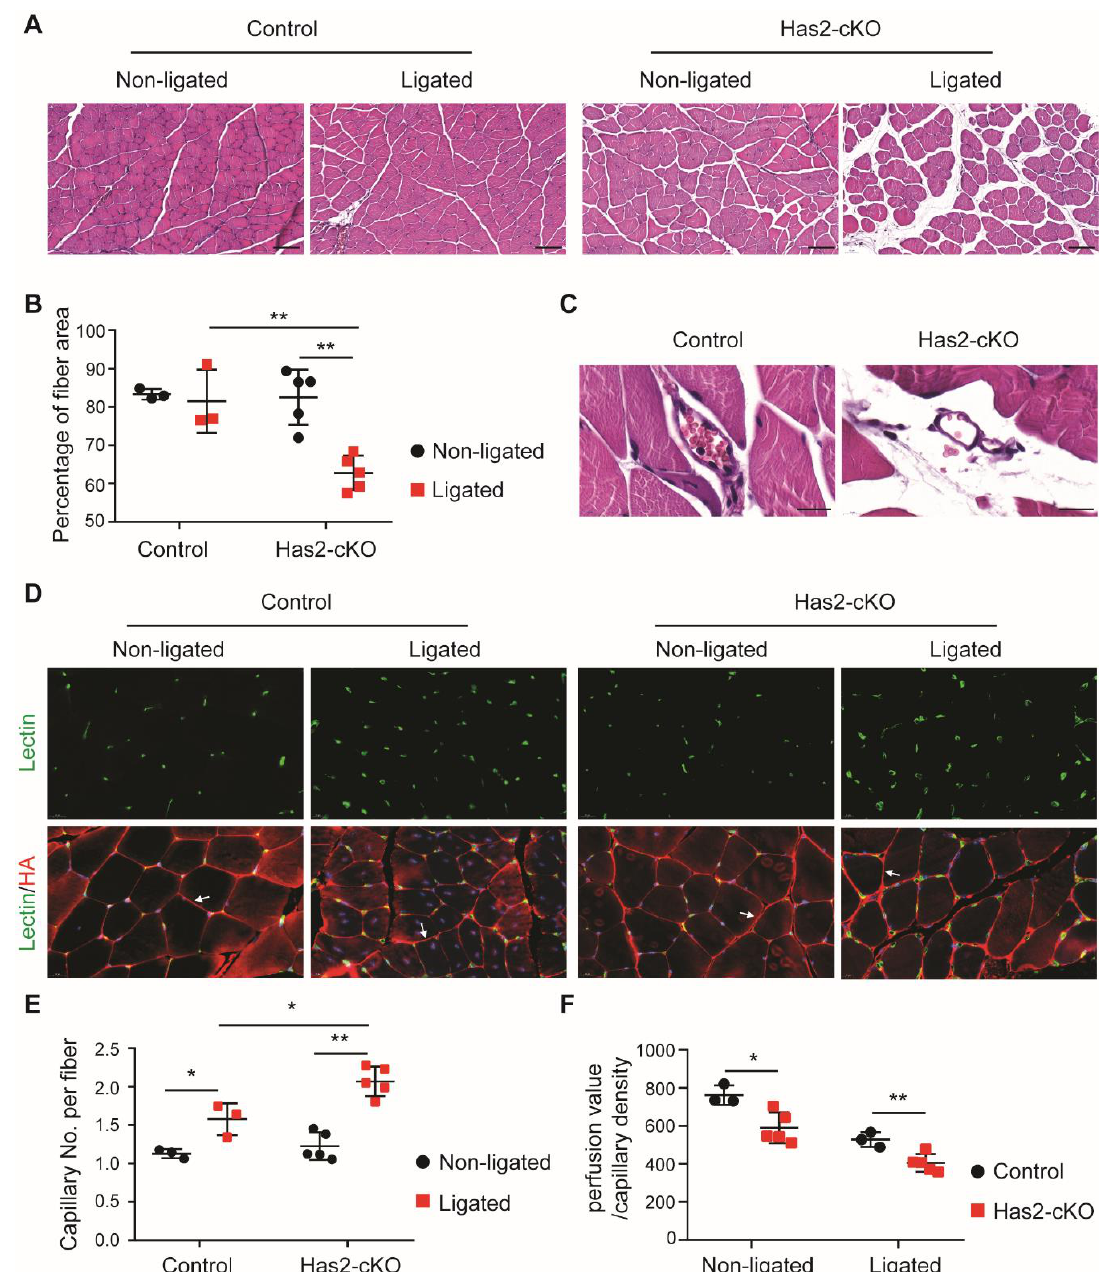
Figure 2. Loss of hyaluronan in ECs leads to muscle damage and excessive angiogenesis after femoral artery ligation. ( A ) Representative images of H&E staining and ( B ) quantification of myocyte area in ligatedandnon-ligatedadductormuscleofHas2-cKO( n = 5)andcontrol( n = 3)mice(scalebar = 100 µ m). ( C ) Representative images of H&E staining show leaky vessels in Has2-cKO mice ( n = 5) after single femoral artery ligation (scale bar = 20 µ m). ( D ) Representative images of BS1-lectin staining for ECs localization (green) and HA staining with the HA binding probe Ncan-dsRed (red). HA staining is used for the myofibroblasts visualization and are found to be surrounded by HA staining as for example depicted by the white arrows. ( E ) quantification of capillary densities in ligated and non-ligated gastrocnemius muscle of Has2-cKO ( n = 5) and control ( n = 3) mice. The capillary density is defined as capillary number per myofibroblast. ( F ) quantification of capillary perfusion capacity, calculated from measured LDPI perfusion value, normalized by capillary density in Has2-cKO ( n = 5) and control ( n = 3) mice after fully recovery. Values are given as mean ± SD. * p < 0.05, ** p <